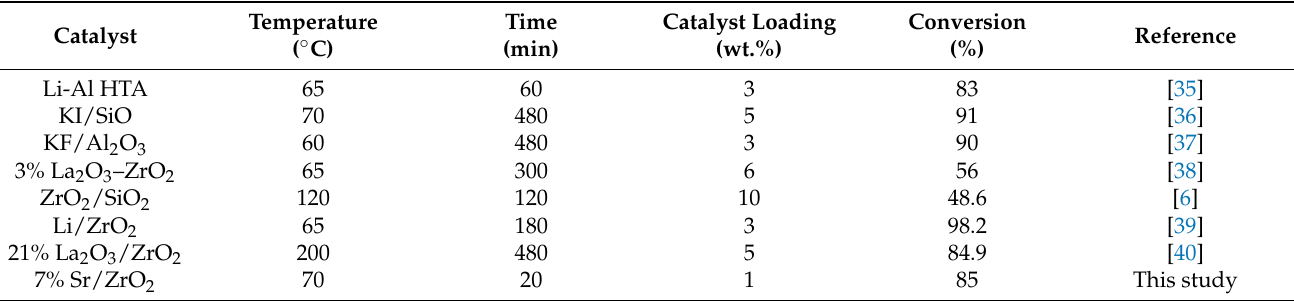
Table 3. Comparison of the current study with other heterogeneous catalysts used for biodiesel production.